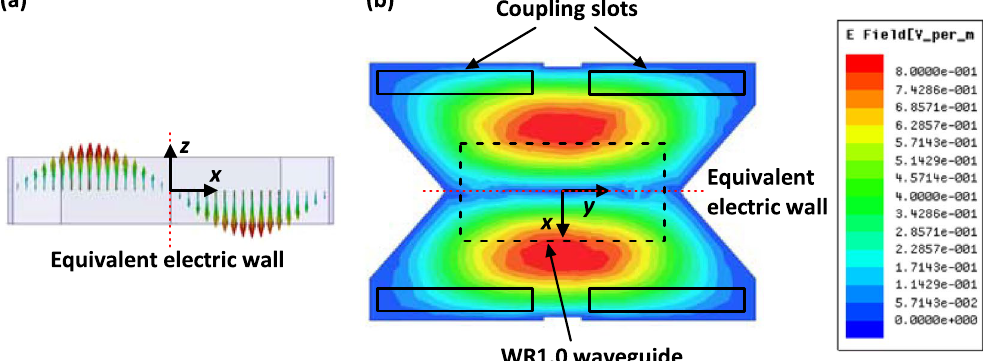
Figure 7. Simulated field distributions in the air cavity. ( a ) Vector distribution and ( b ) magnitude